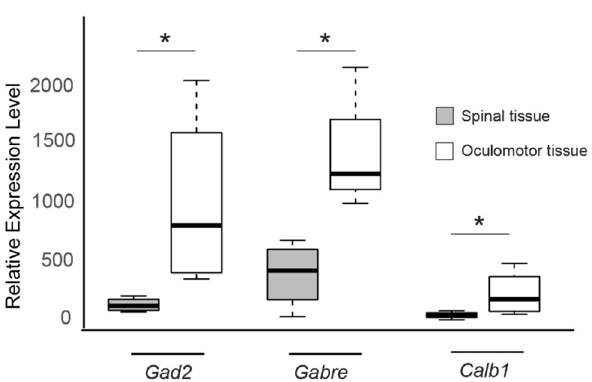
Figure 4. Expression levels of GAD2 , GABRE , and CALB1 genes are high in oculomotor tissue. Boxplot comparisons of relative gene expression level of GAD2 , GABRE , and CALB1 in GSE40438, when comparing expression in control lumbospinal neurons and oculomotor neurons. Boxes are interquartile ranges. Bars are the non-outlier range as defined by R software. * p < 0.05.